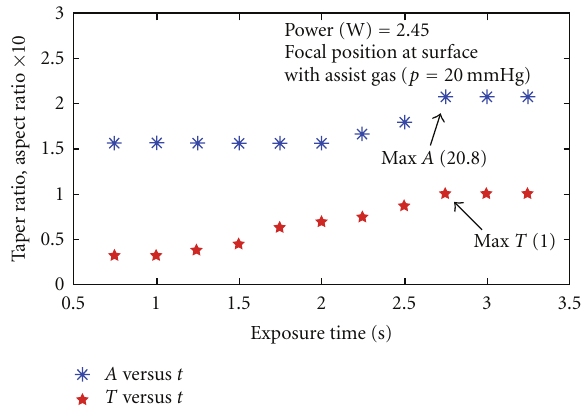
Table 1: The theoretical values of the aspect and taper ratios at di ff erent powers.